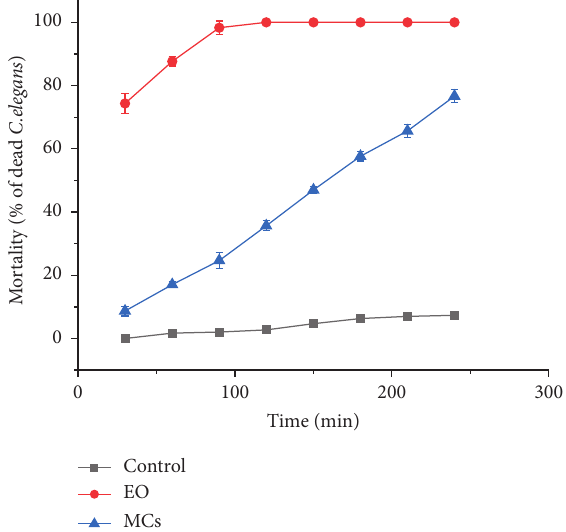
Figure 3: Average mortality (%) in comparative nematicide activity of essential oil (EO) and microcapsules (MCs). Results show at least three independent biological replicates. Error bars represent the standard error and differences compared to the